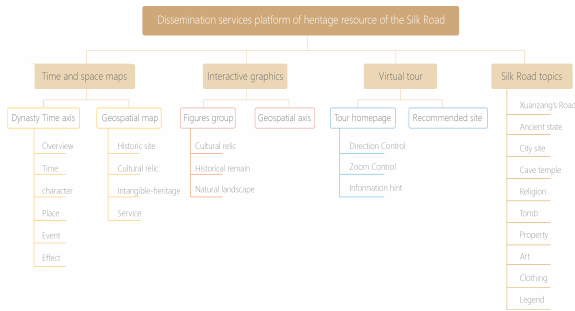
Figure 2: Dissemination services platform information architecture of heritage resource of the Silk Road